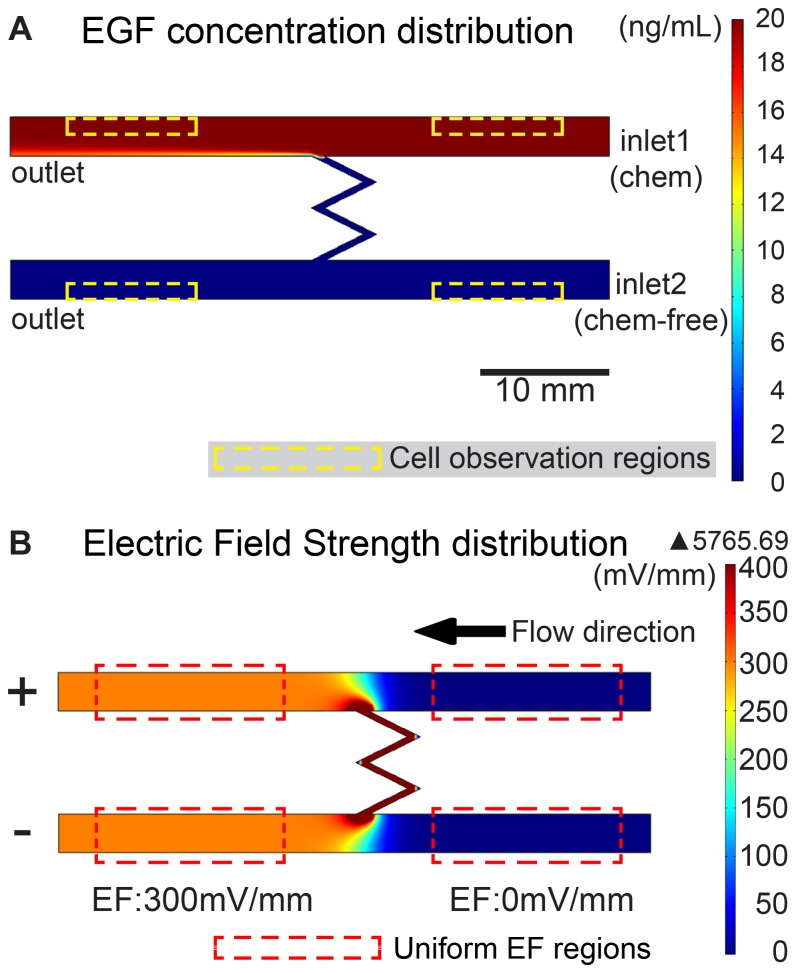
Simulated chemical concentration and electric field distribution of the dual-field chip.(A) The geometry and EGF concentration distribution in the dual field chip. Note that even for a small protein like EGF, only a small portion of it would be transported and create localized chemical gradient. Regions for cell observation are outlined in yellow dash lines. (B) The dcEF strength distribution in the dual field chip. Note that cell electrotaxis and random migration (control) with and without EF can be studied in a single chip. Regions with uniform EF distribution are outlined in red dash lines.